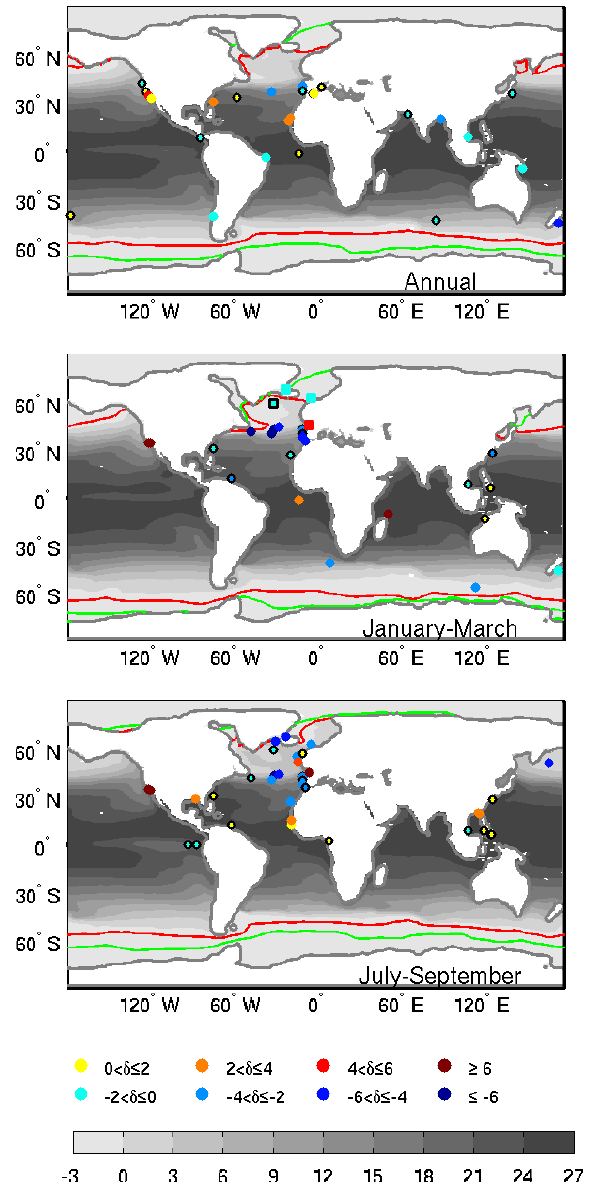
Fig. 3. Simulated SST (grey shading) and the difference δ be- tween simulated and proxy SST (coloured circles/squares) for an- nual mean (top panel), January–March (middle panel), and July– September (bottom panel). The circle/square is surrounded by a black line at sites where k δ k≤ (the uncertainty in the proxy SST). Unit ◦ C. Sea ice covered (sea ice free) proxy sites are plotted with squares (circles). The simulated sea ice edge, defined at 50% areal sea ice cover, is also displayed for GS12 (red line) and RP (green line). The coastline is defined at 20% of the land